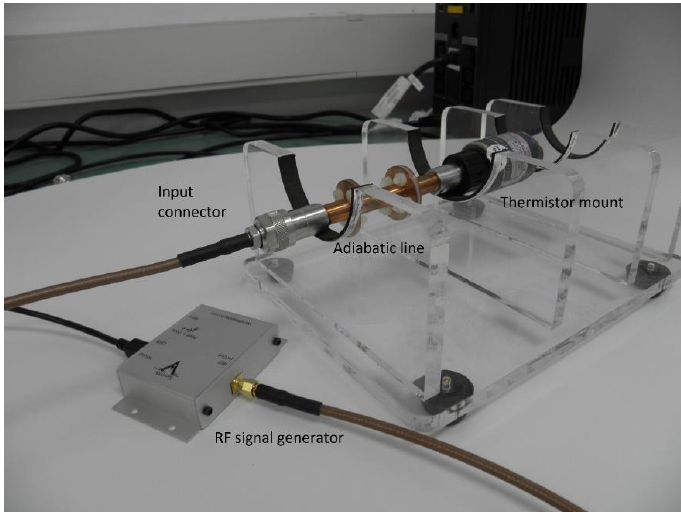
Figure 19. Calculated and measured mismatch factor—Equation (3) .